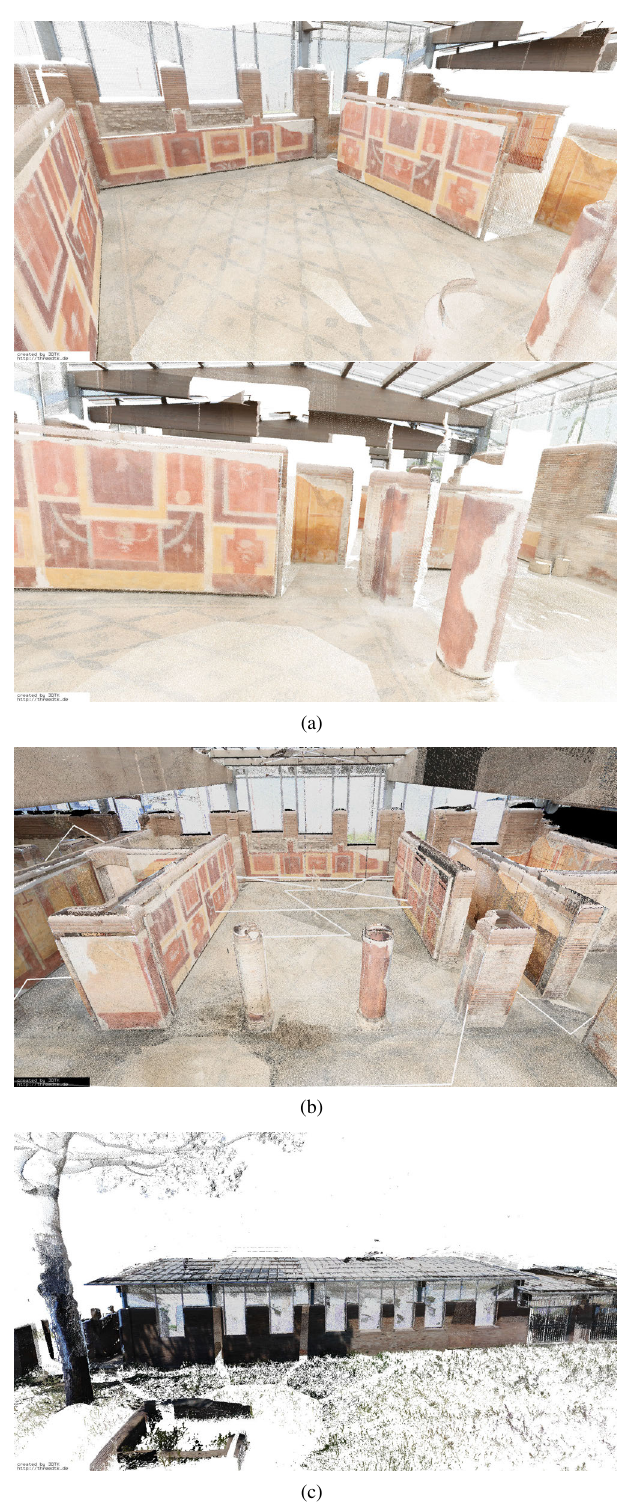
Figure 6: The model of the garden house in Ostia Antica. (a) two views of the data acquired on the first day. (b) The complete model with data from all days. The white lines mark the scanning sequence. (c) Outside view of the complete model.